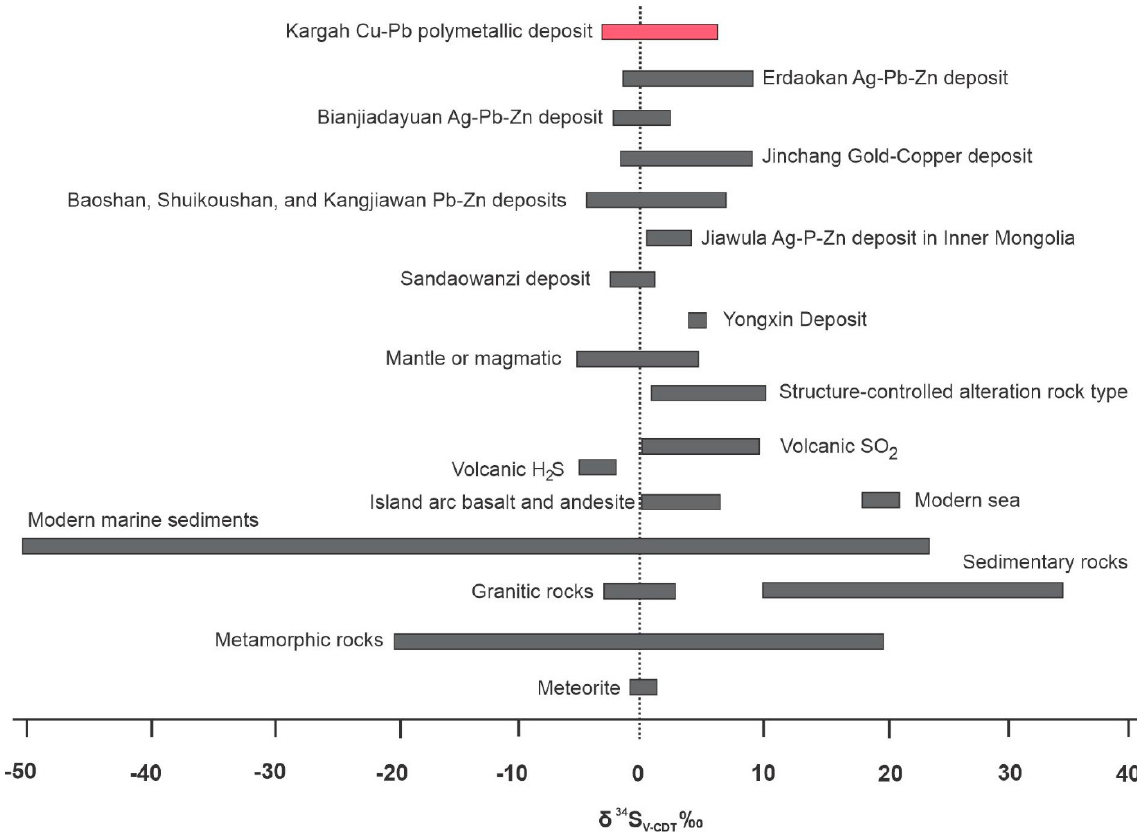
Figure 15. Sulfur isotopic compositions of the Kargah Cu-Pb polymetallic deposit as compared with the magmatic-hydrothermal deposits and other geological settings, (after [9,43,44]); data of the Erdaokan Ag-Pb-Zn deposit from Yuan et al. [43]; Bianjiadayuan Ag-Pb-Zn deposit from Zhai et al. [104]; Jiawula Ag-P-Zn deposit from Niu et al. [85]; Sandaowanzi deposit from Zhai et al. [105]; Jinchang Gold-Copper deposit from Li et al. [100]; Baoshan, Shuikoushan, and Kangjiawan Pb-Zn deposits from Zou [109]; Yongxin deposit from Yuan et al. [44].